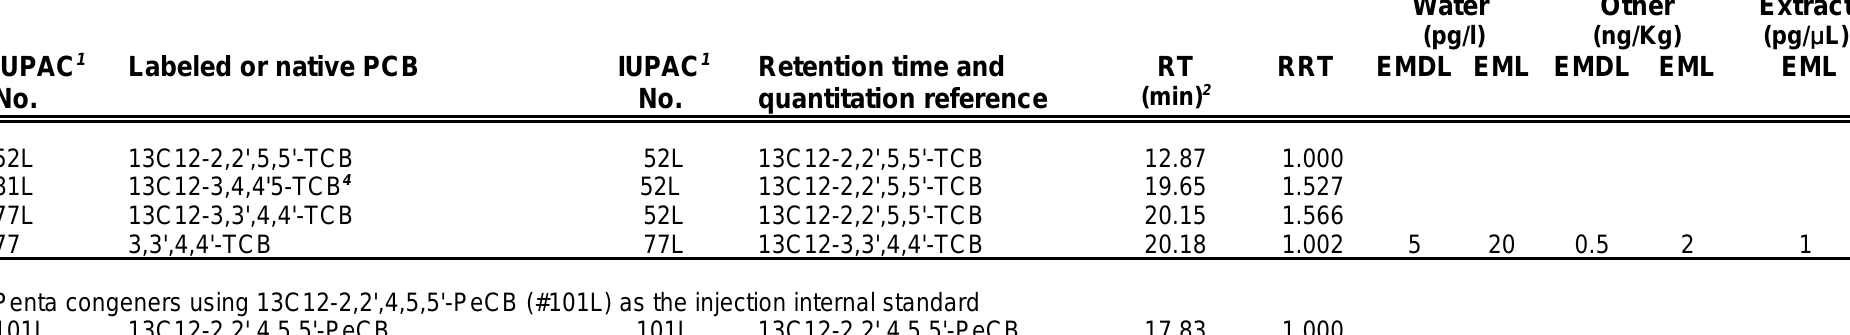
Table 2. Retention Time (RT) References, Quantitation References, Relative Retention Times (RRTs), Estimated Method Detection Limits (EMDLs), and Estimated Minimum Levels (EMLs) for the Toxic PCBs a